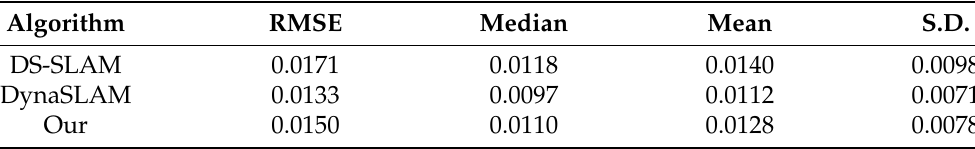
Figure 8. Comparison of tracks in different directions. Table 6. APE comparison (APE includes RMSE [m], Median [m], Mean [m], S.D.